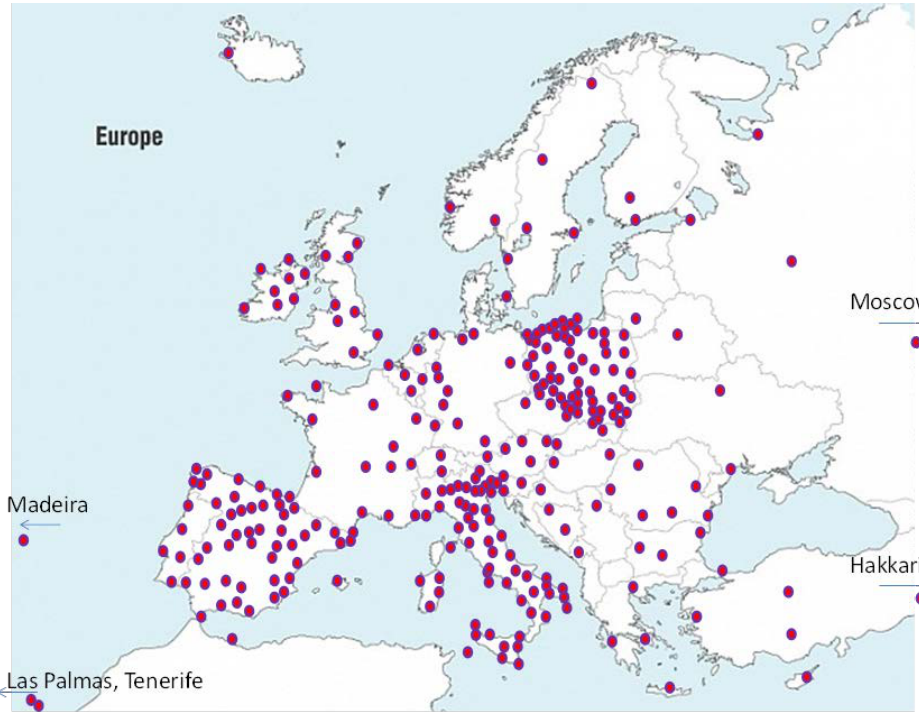
Figure 2. Locations selected from METEONORM and ENERGYPLUS database to create a European wide database.